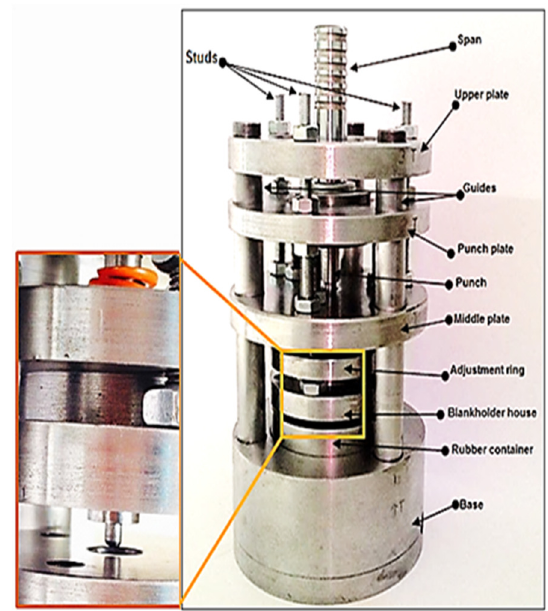
Fig. 8. Flexible too-assisted micro deep drawing device.